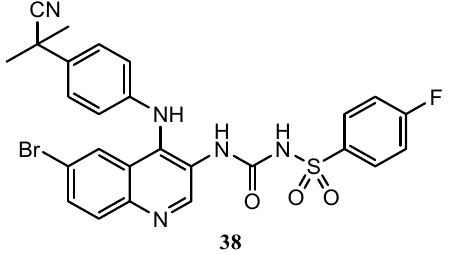
Figure 12. The most active derivative of 3-phenylsulfonylurea-4-aniline quinoline series